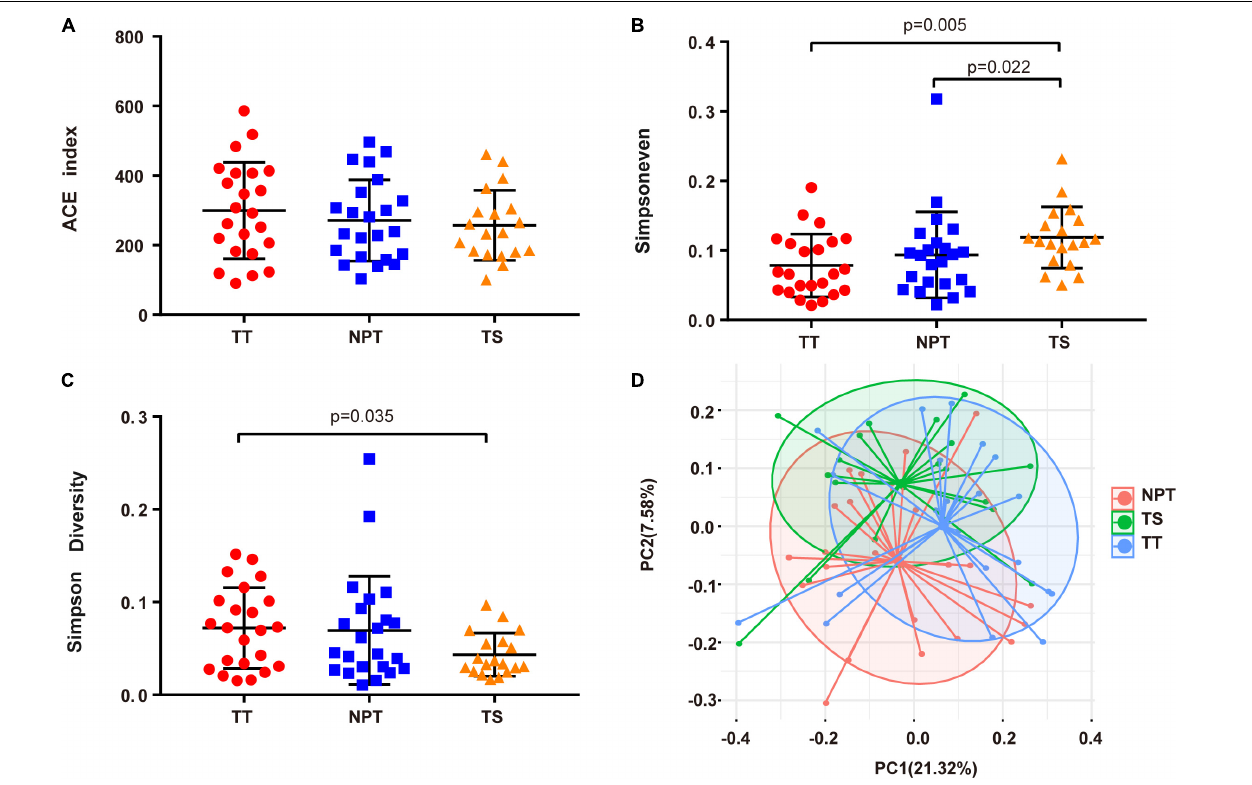
FIGURE 1 | Comparison of alpha and beta diversity in TT, NPT, and TS groups. (A) ACE index, (B) Simpsoneven, (C) Simpson diversity, and (D) Principal Coordinate Analysis (PCoA) based on weighted UniFrac distance metrics.